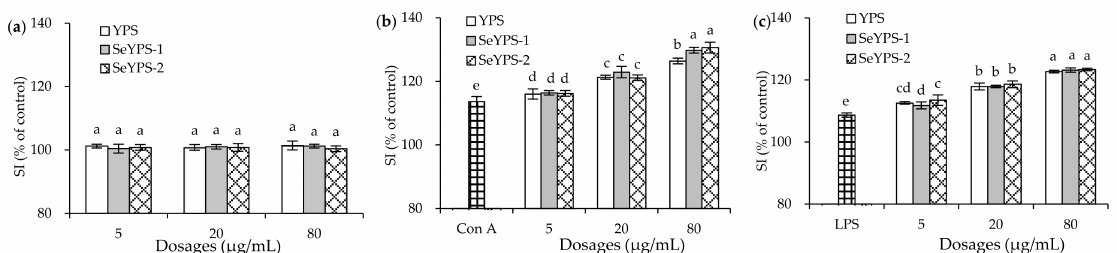
Figure 3. The measured SI values of the splenocytes exposed to YPS, SeYPS-1, and SeYPS-2 for 48 h without the mitogen ( a ) and accompanied with Con A ( b ) or LPS ( c ). Different letters above the columns indicate that the one-way ANOVA of the mean values differs significantly ( p <